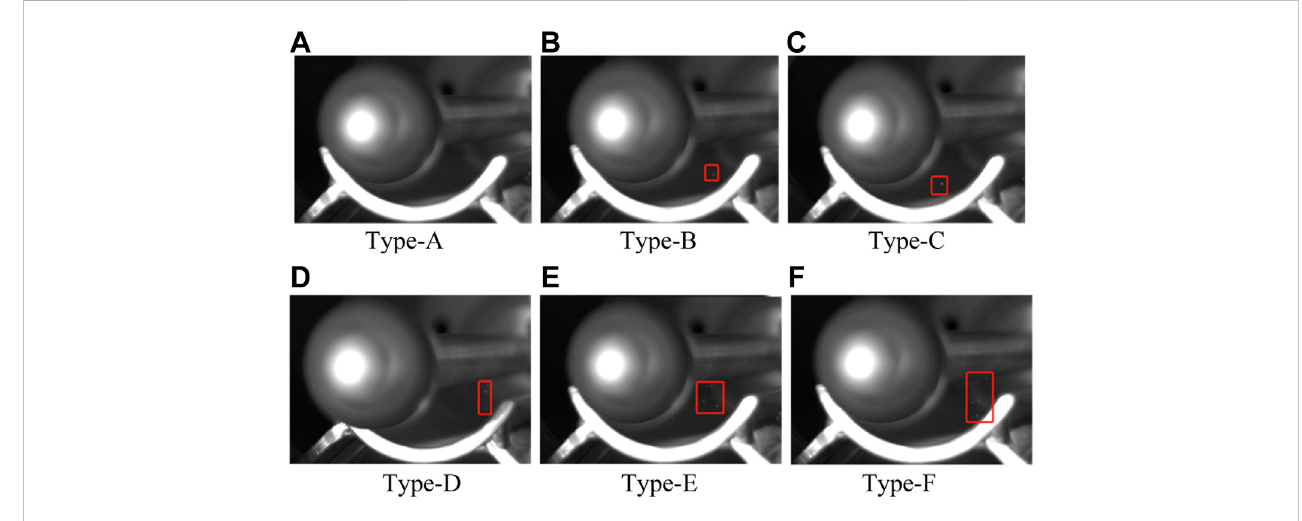
FIGURE 6 Movement images of free-conducting particles.